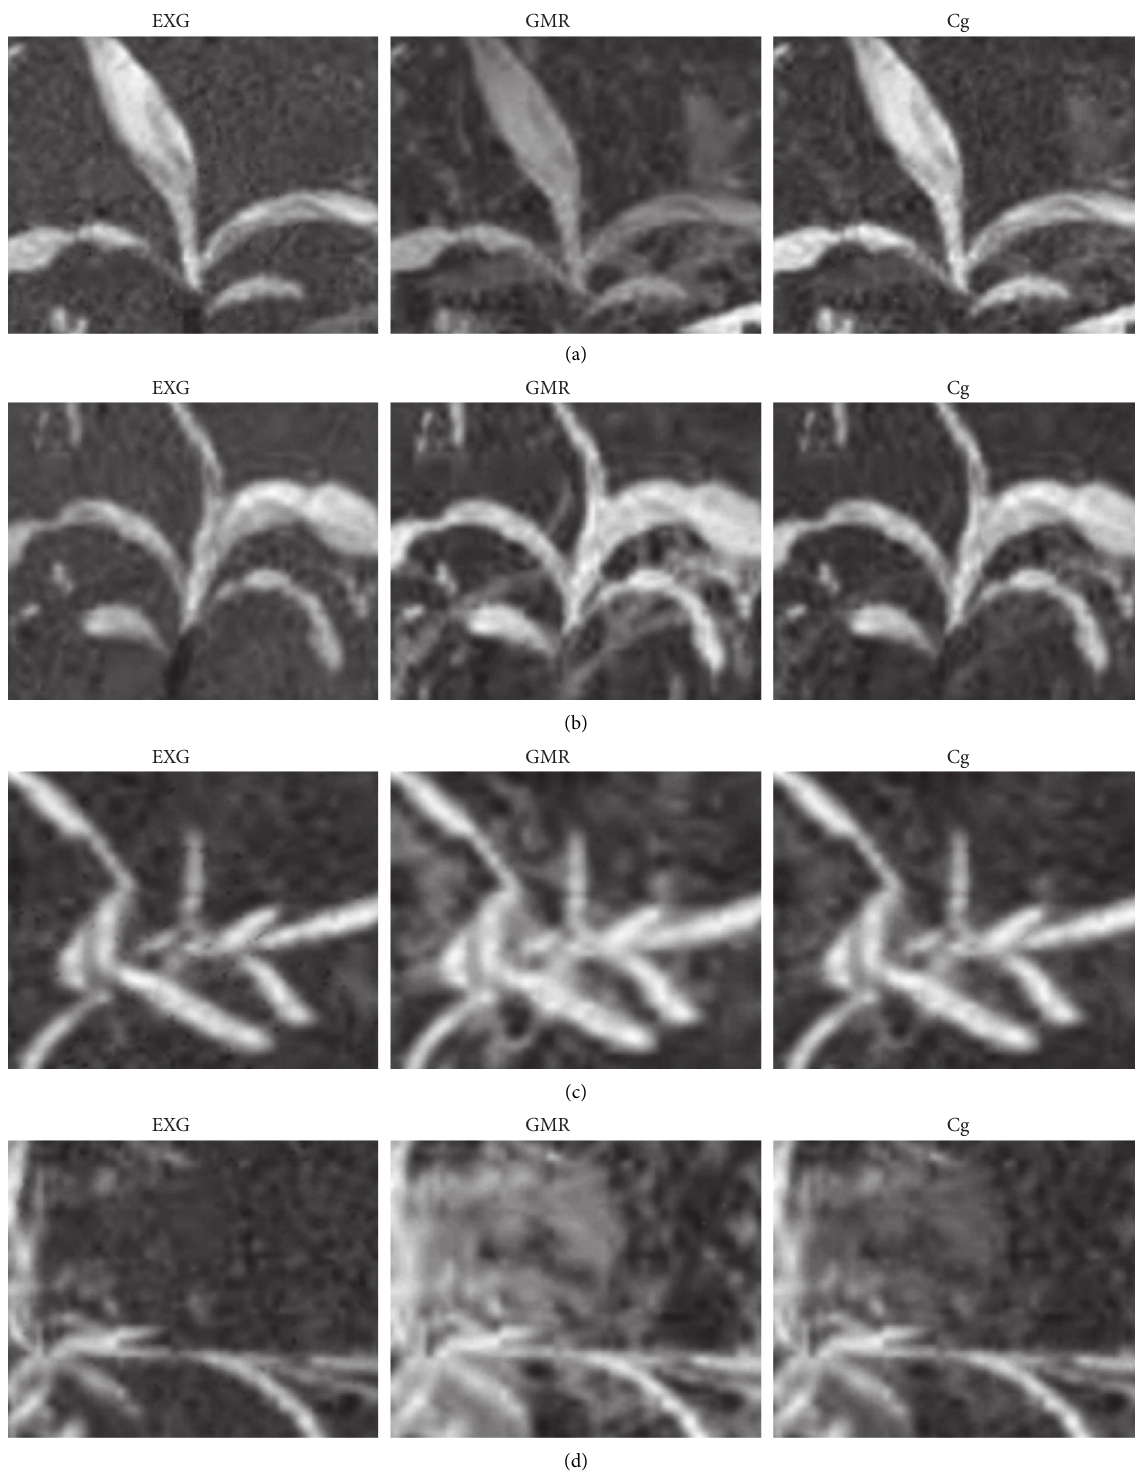
Figure 7: Experimental results of grayscale image